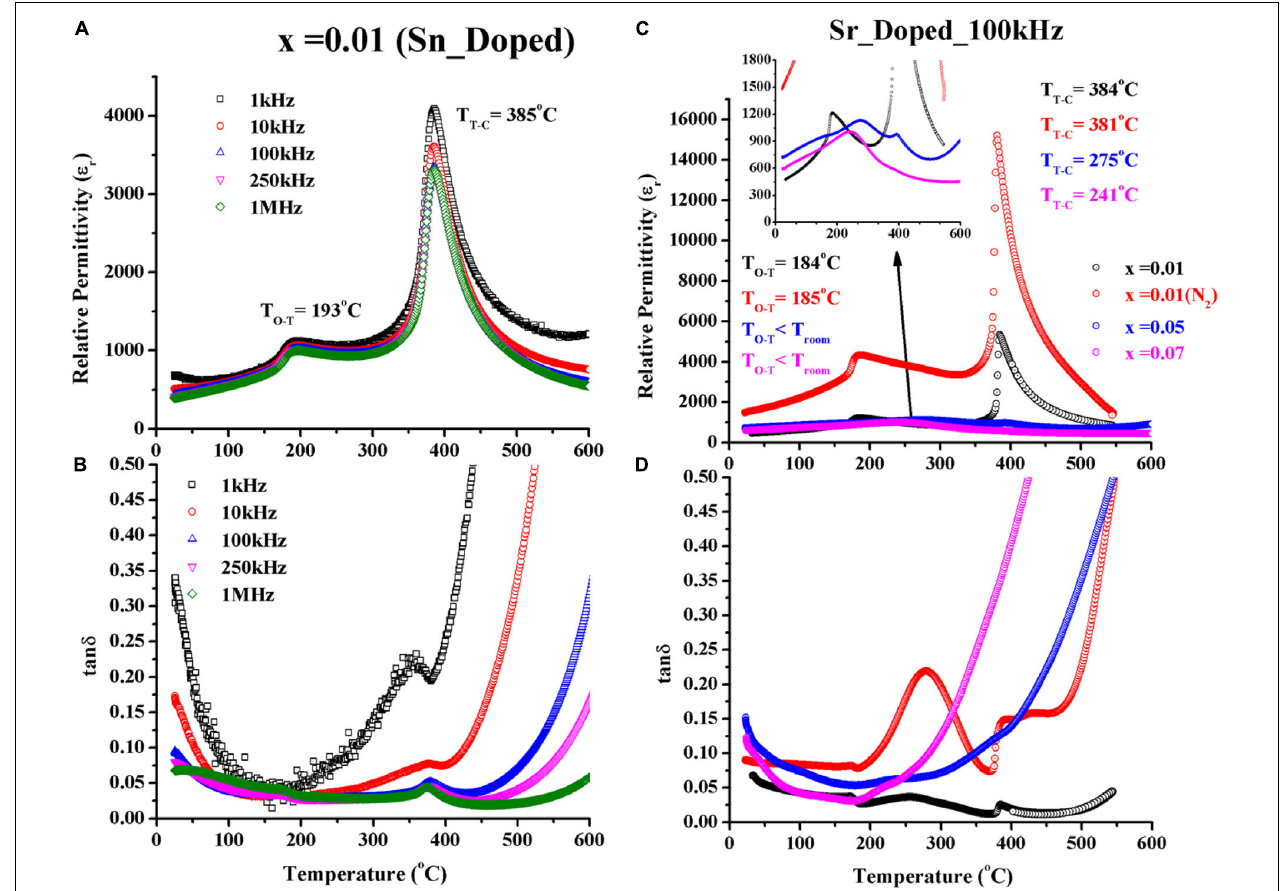
FIGURE 6 | (A) ε r and (B) tan δ verses temperature of Sn-doped KNN; (C) ε r and (D) tan δ verses temperature of Sr-doped KNN compositions.